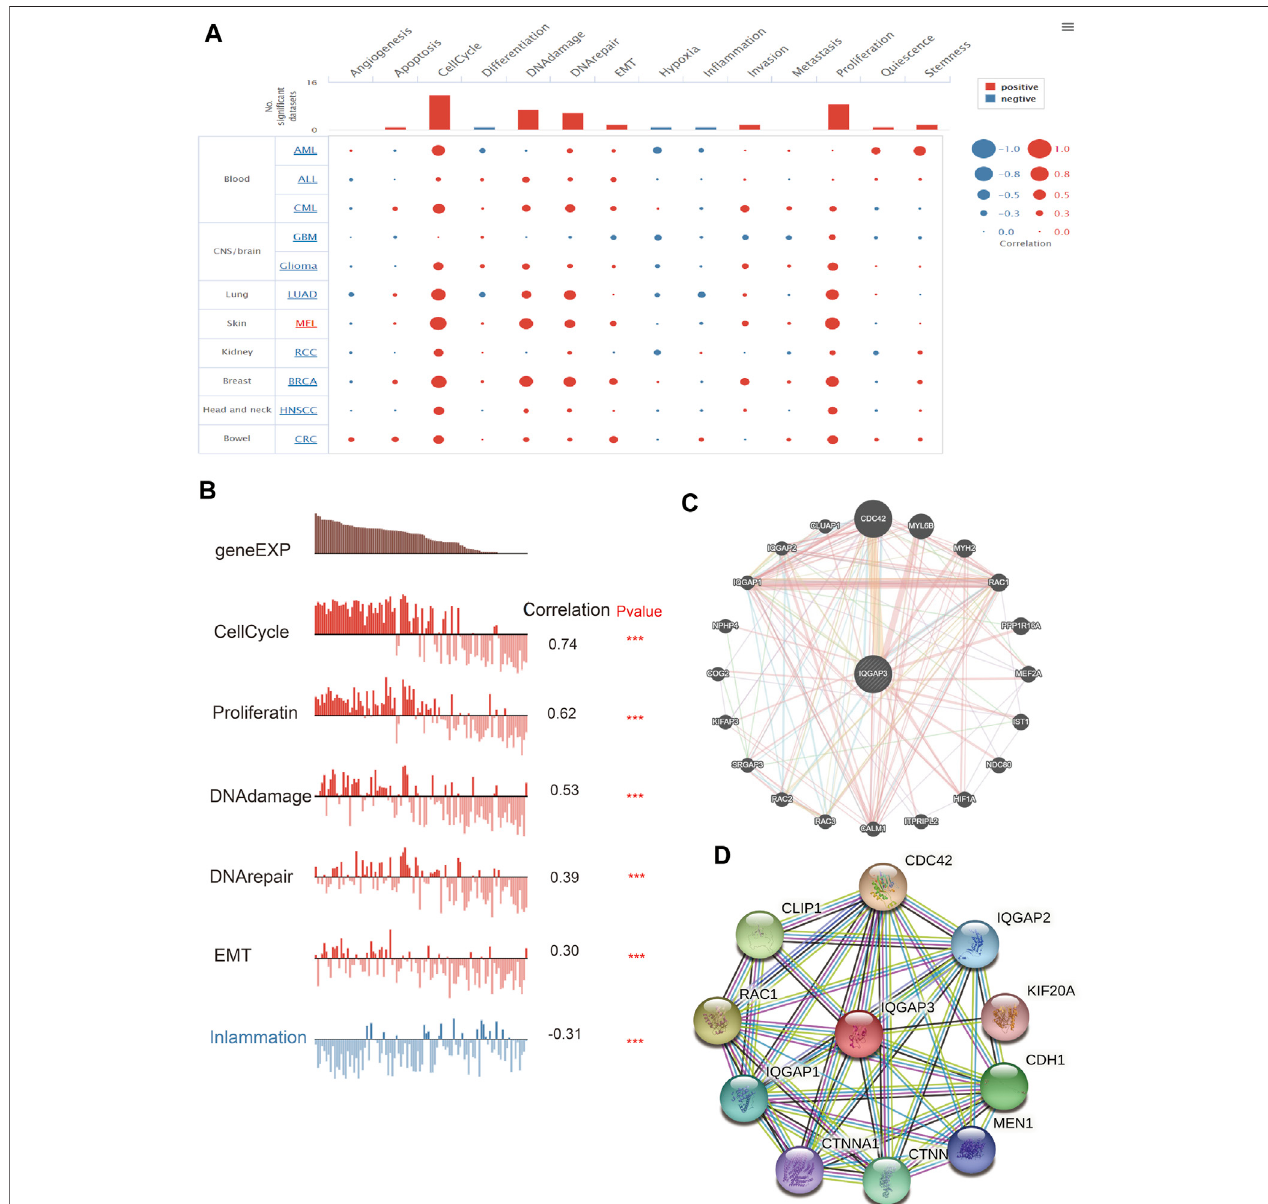
FIGURE 7 | Analysis of the function for IQGAP3 in human cancers. (A) The function of IQGAP3 in pan-cancer analysis by using the CancerSEA database. (B) The correlationbetweentheIQGAP3anddiversefunctionanalysisbyusingtheCancerSEAdatabase. (C) ThegeneinteractionmeshworkofIQGAP3wasconstructedusing GeneMania. (D) The STRING database was employed to construct the protein interaction meshwork of IQGAP3.